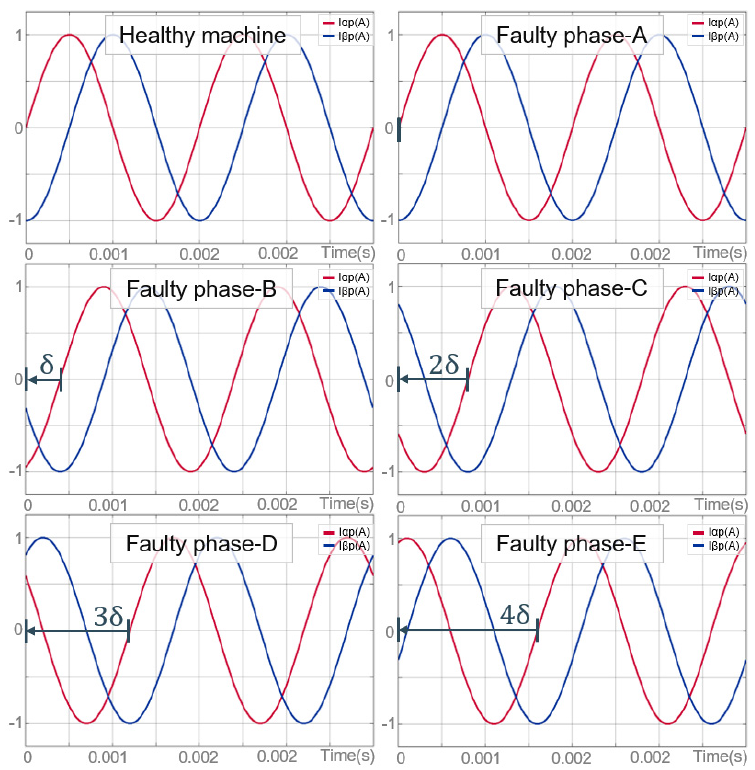
Figure 6. Waveforms of the Clarke transforms outputs in different phase loss conditions.